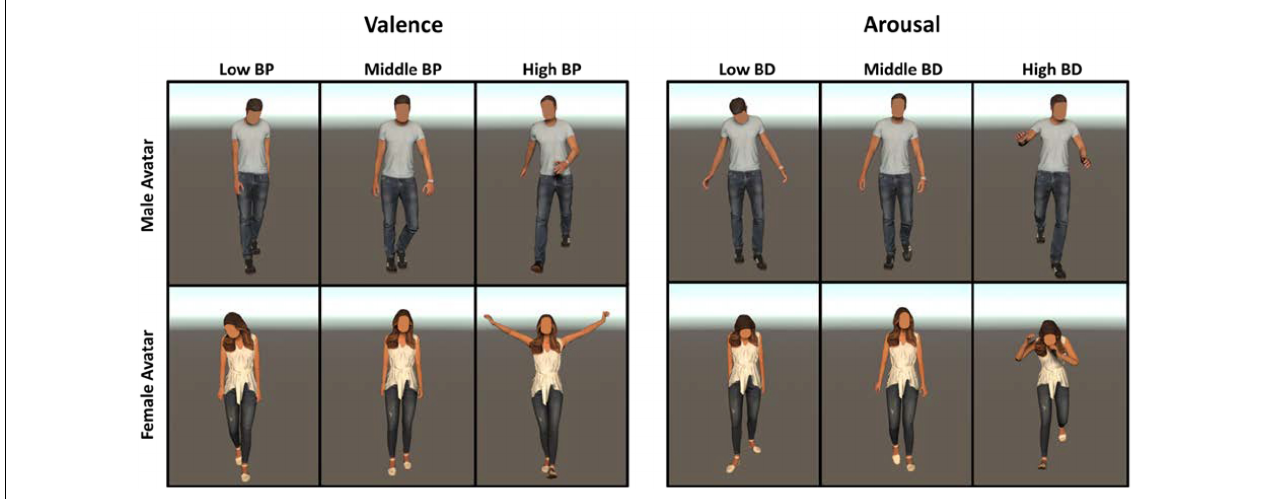
FIGURE 6 | Example of avatar’s body postures with different levels of BP (Right panels) and BD (Left panels) used in Experiment 2. We assigned the body postures represented in Figure 3 to the gender-opposite avatar.